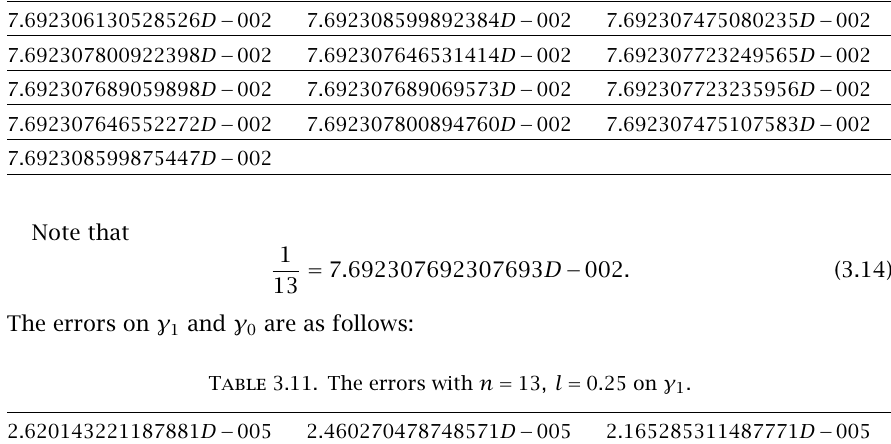
Table 3.10 . The charge distribution with n = 13 , l = 0 . 25 on γ 0 .